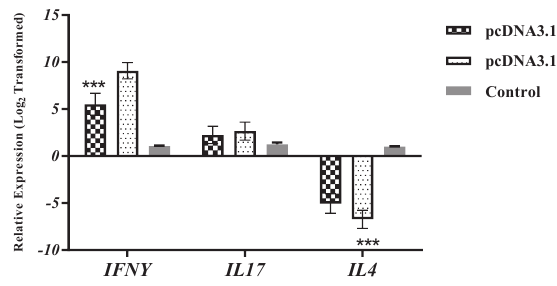
Figure 5. Comparison of the expression pattern of all three cytokines (i.e., IL4, TGF- β 1, and IFN γ ) in injected BALB/c mice by pcDNA3.1(+)- cagT + nanoparticle and pcDNA3.1(+)- cagT compared with the control (infused by empty pcDNA3.1(+) vector).